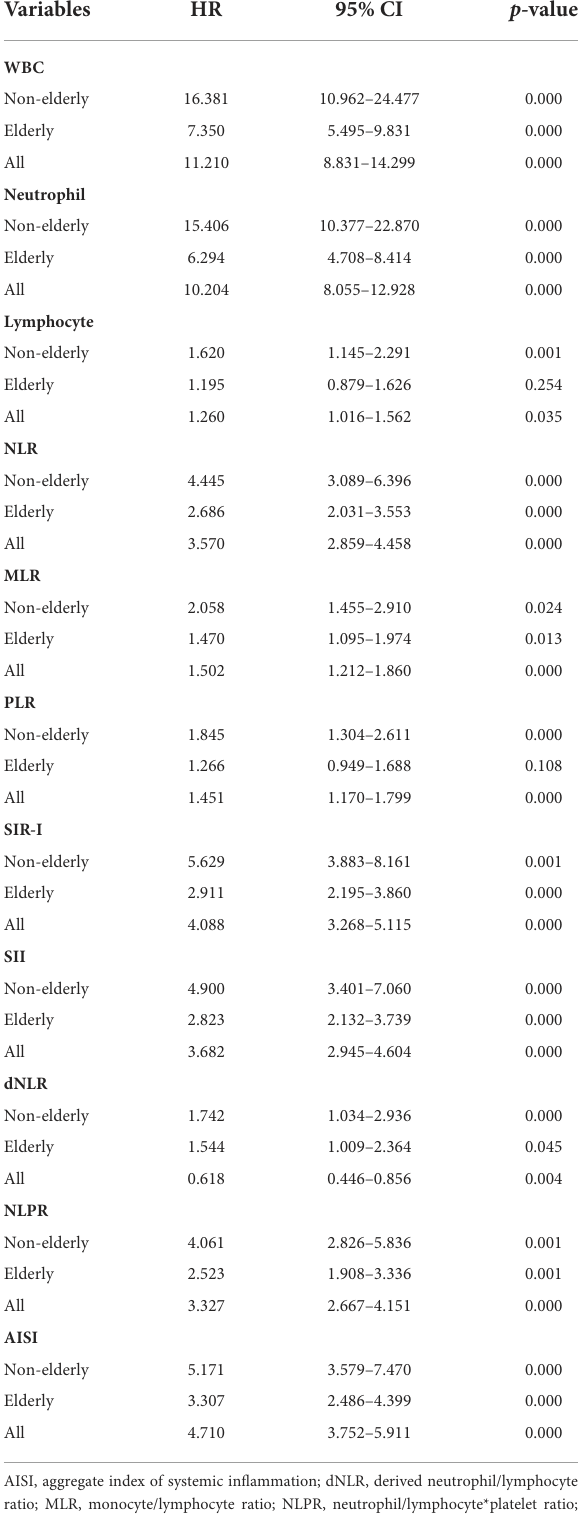
TABLE 4 Hazard ratios of the indexes under investigation obtained by Cox regression analysis in non-elderly and elderly COVID-19.